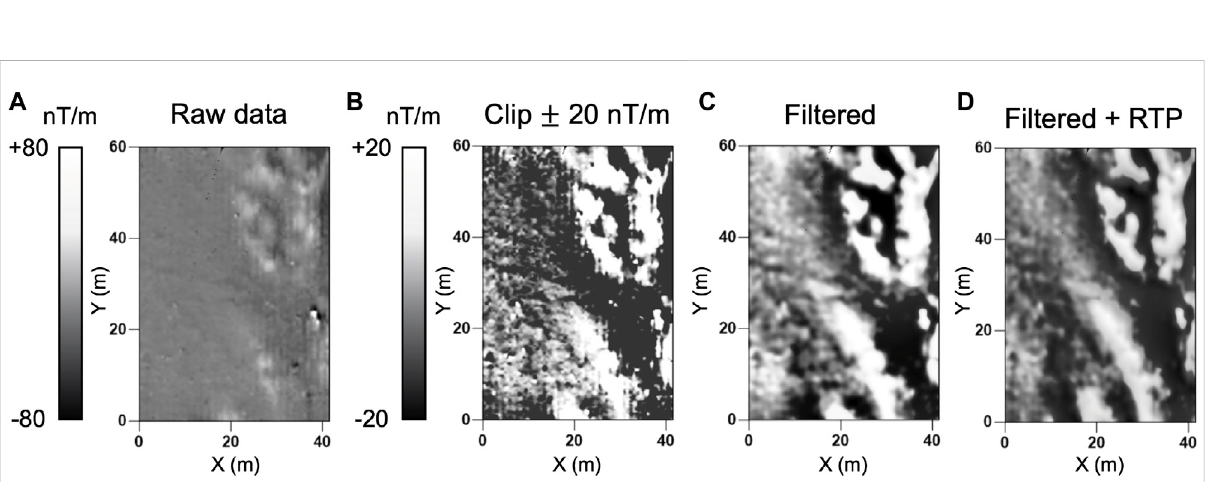
FIGURE 4 Processing results of several steps in area A1. The raw data (A) allow one to de fi ne the range of amplitude values to be considered. We can observe that most amplitudes are de fi ned between ±20 nT/m (B) . The fi lters mitigated the striped effect (C) , and the reduction to the magnetic pole corrects the position of the anomaly map (D)